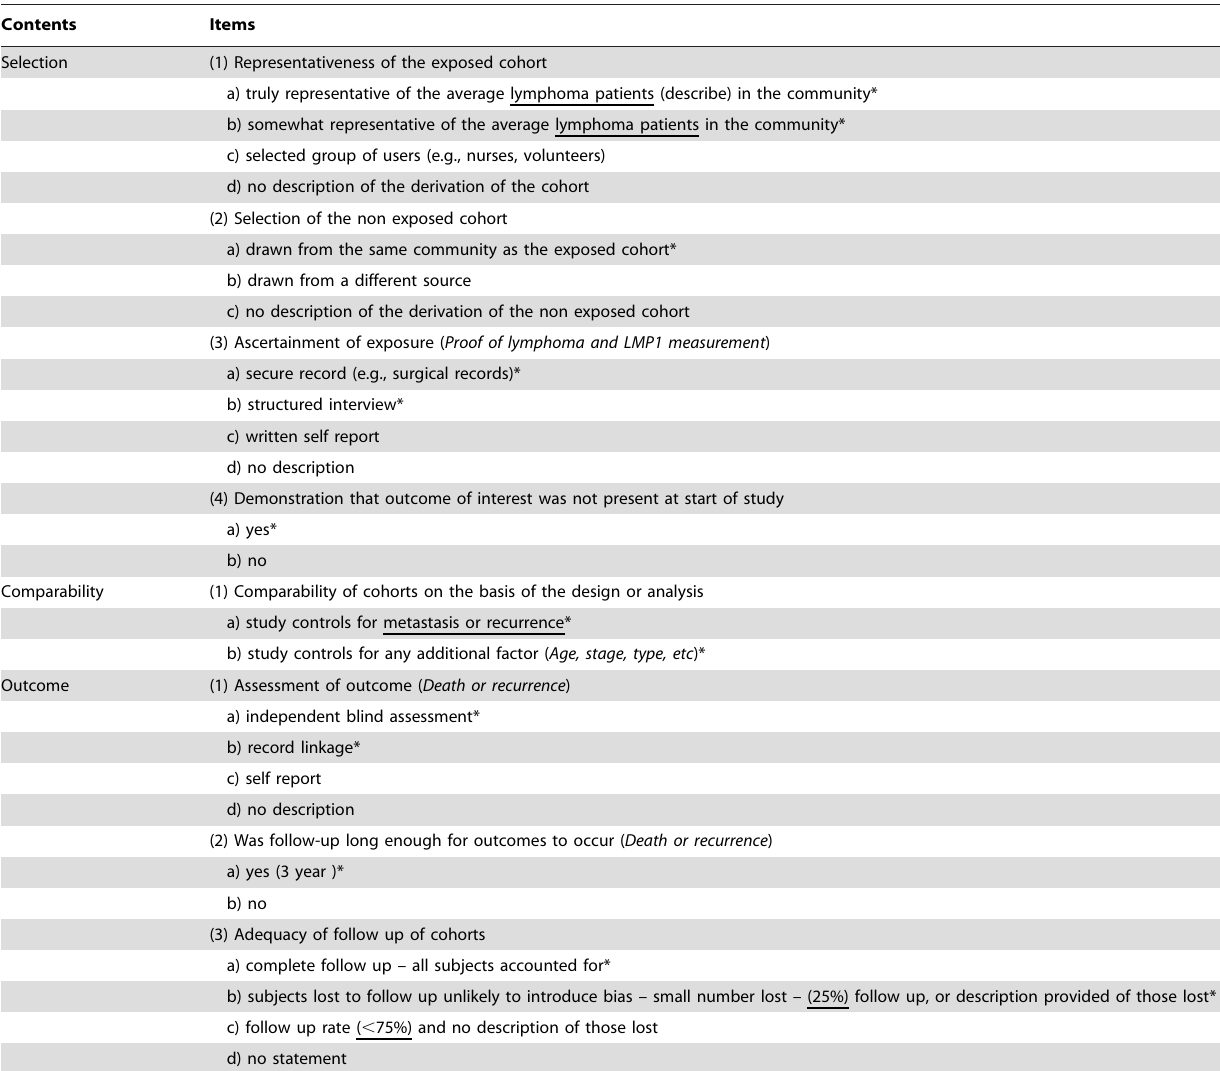
Table 1. Newcastle-Ottawa quality assessment